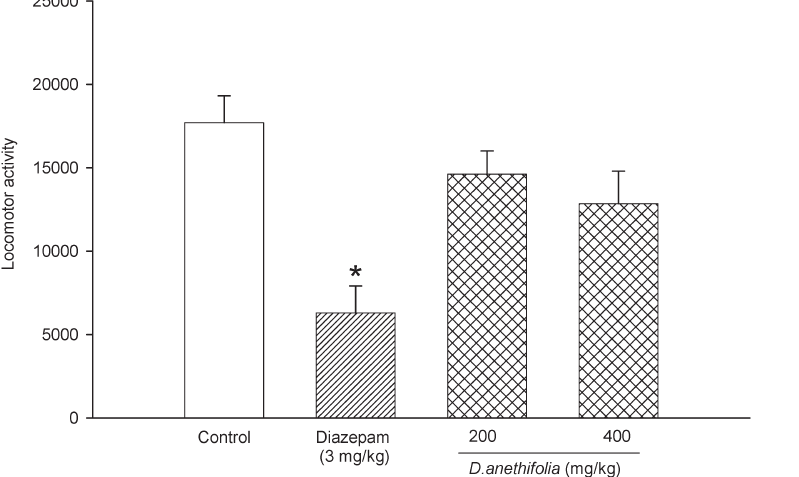
Figure 3 - Effects of diazepam, saline, and different doses of D. anethifolia on spontaneous locomotor activity during a total of 15 minutes. The locomotor activity counts (mean ¡ S.E.M.) were measured over a 15-minute period, beginning 30 minutes after the administration of saline, diazepam, or different doses of D. anethifolia . *P , 0.01 compared with